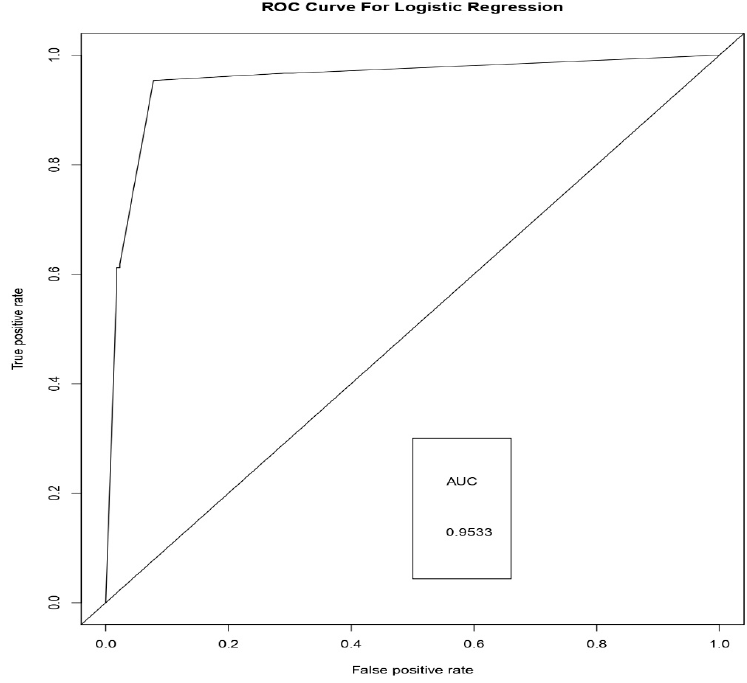
Figure 6. AUC-ROC curve for Logistic Regression Approach.